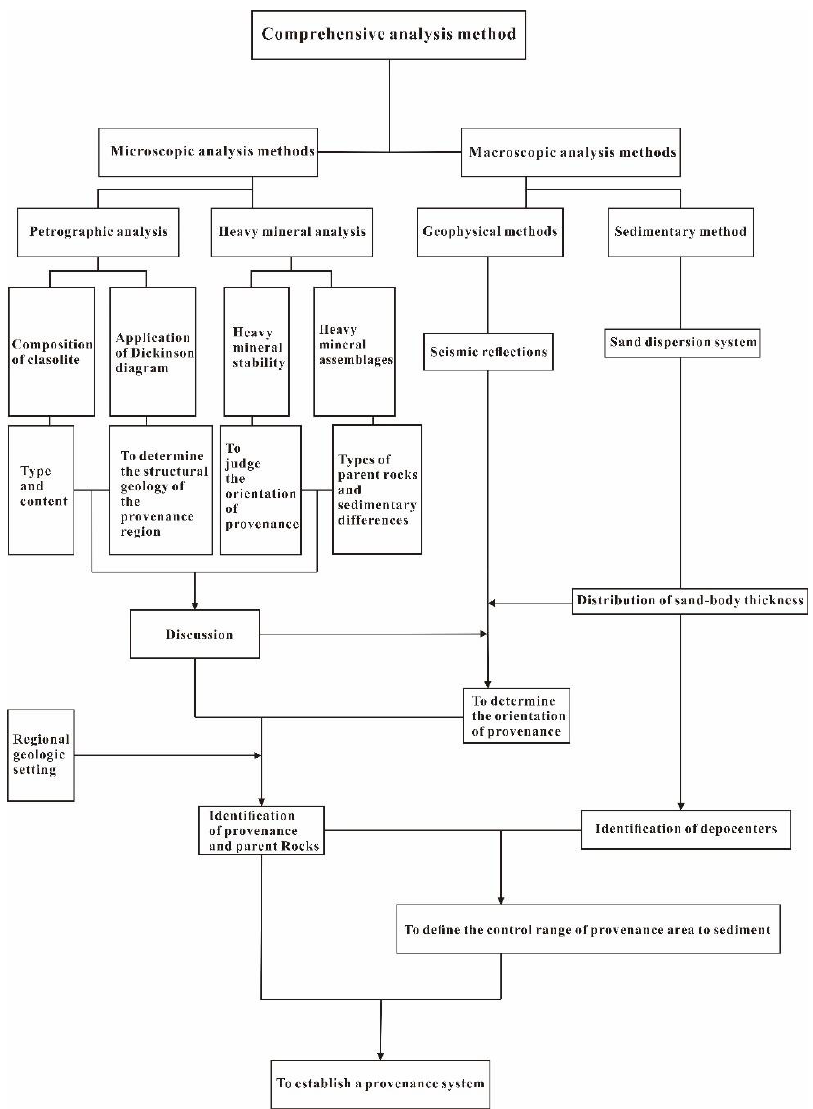
Figure 1. Flowchart of comprehensive provenance analysis method.